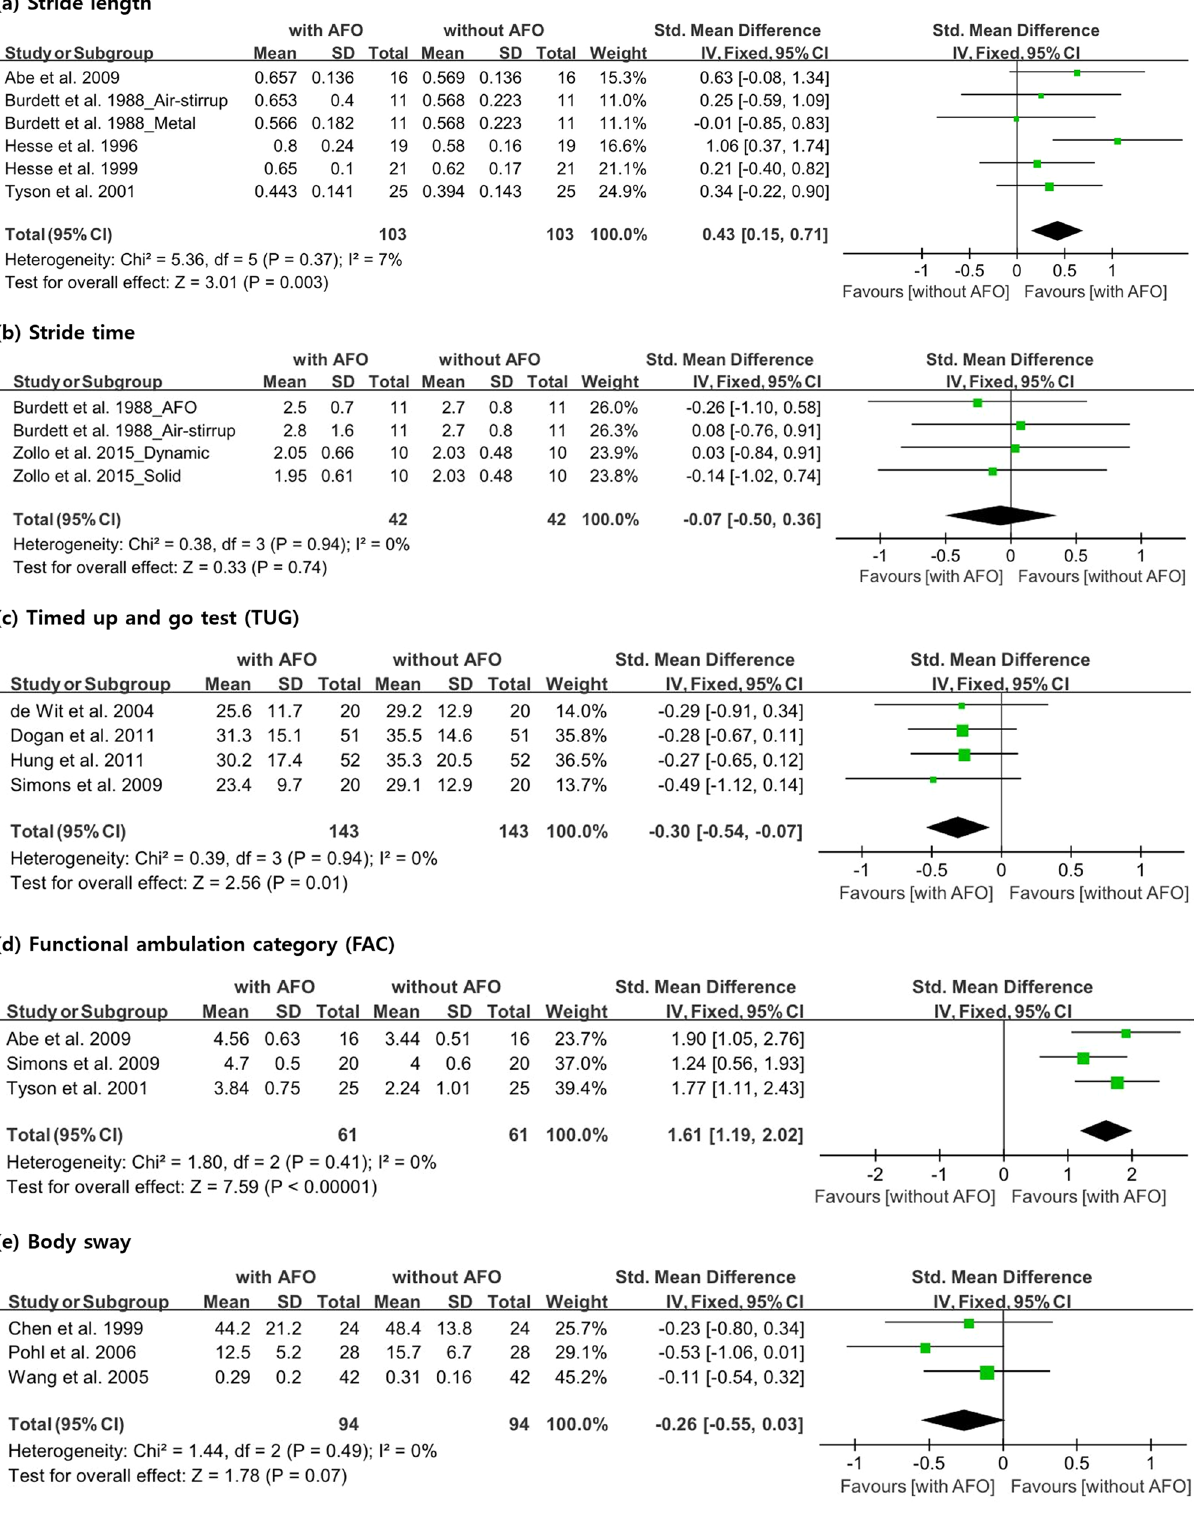
Figure 3. Forest plot showing the results of ( a ) stride length, ( b ) stride time, ( c ) timed up-and-go test, ( d ) functional ambulation category and ( e ) body sway with or without ankle–foot orthosis